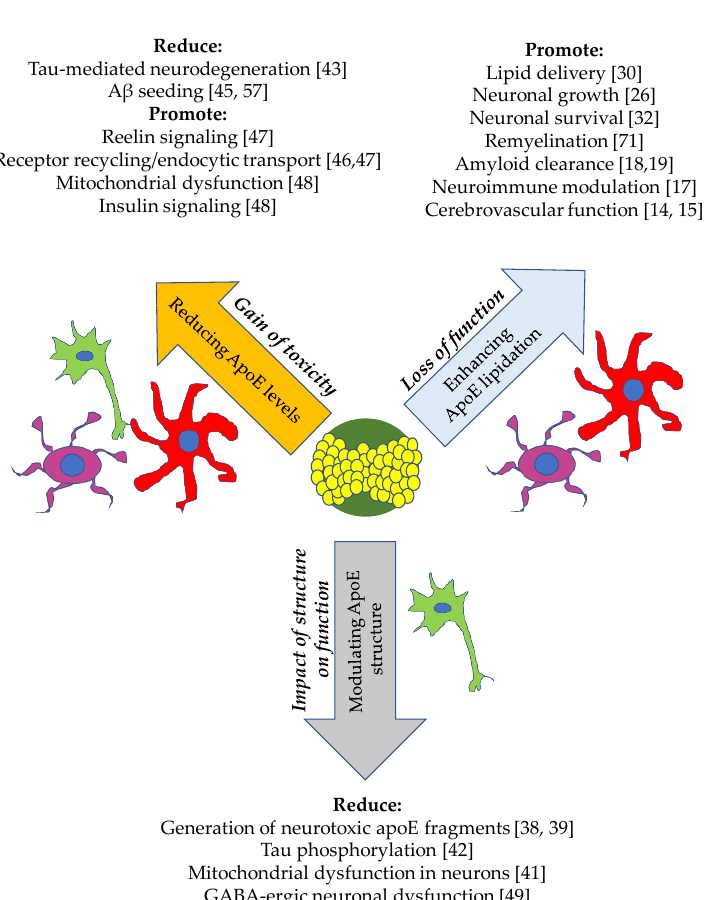
Figure 2. Multiple hypotheses for targeting apoE and their downstream effects. There are many reported findings in the literature which support the hypotheses (italicized) aimed at unveiling the function of apoE in the brain. The approach for targeting apoE in relation to each hypothesis is listed within the arrow. Cell types involved are astrocytes (red), microglia (purple) and neurons (green). A lipidated apoE particle is depicted in the center.